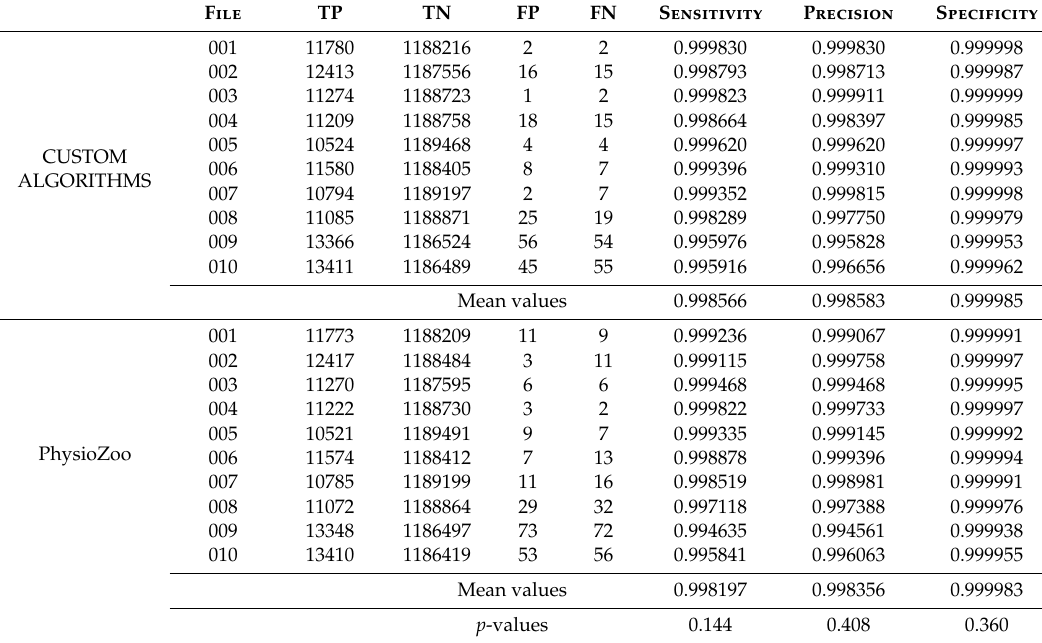
Table 2. Sensitivity, precision and specificity of R-peak detection compared between our automated custom algorithms and PhysioZoo ( n = 10 ECG traces of twenty minutes). F